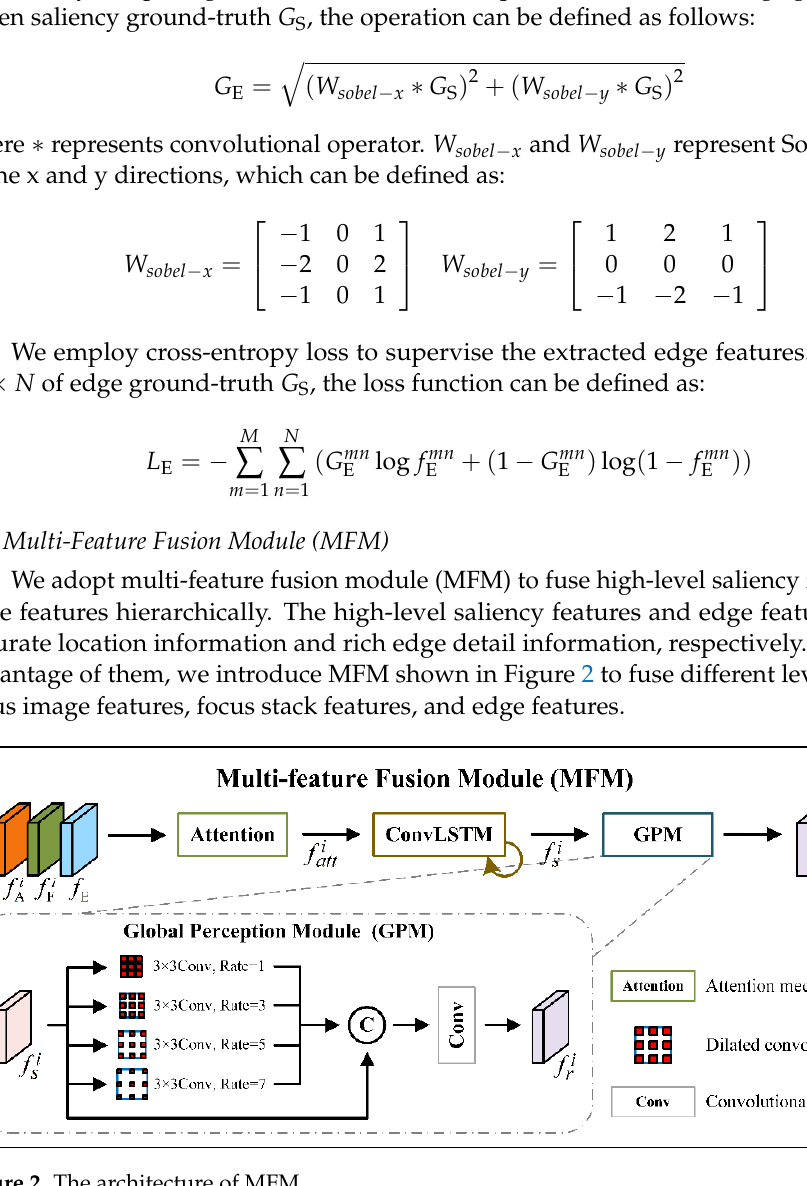
Figure 2. The architecture of MFM.